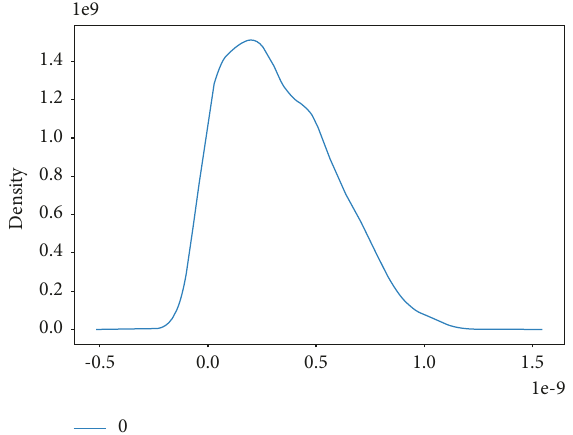
Figure 6: Probability of multivariate Gaussian with Gaussian pyramid 13 ×